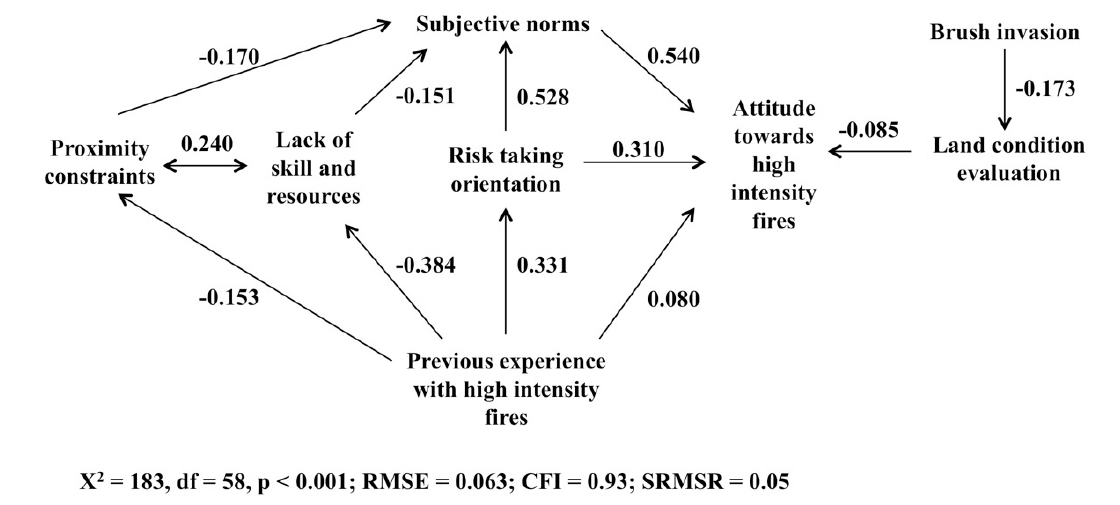
Fig. 3 . Structural-equation model showing the direct effects of experience, brush encroachment, land condition, proximity constraints, risk taking orientation, knowledge, skill and equipment availability, and subjective norms on attitudes toward high-intensity prescribed burns for 520 landowners in 12 Texas Counties. All paths are statistically